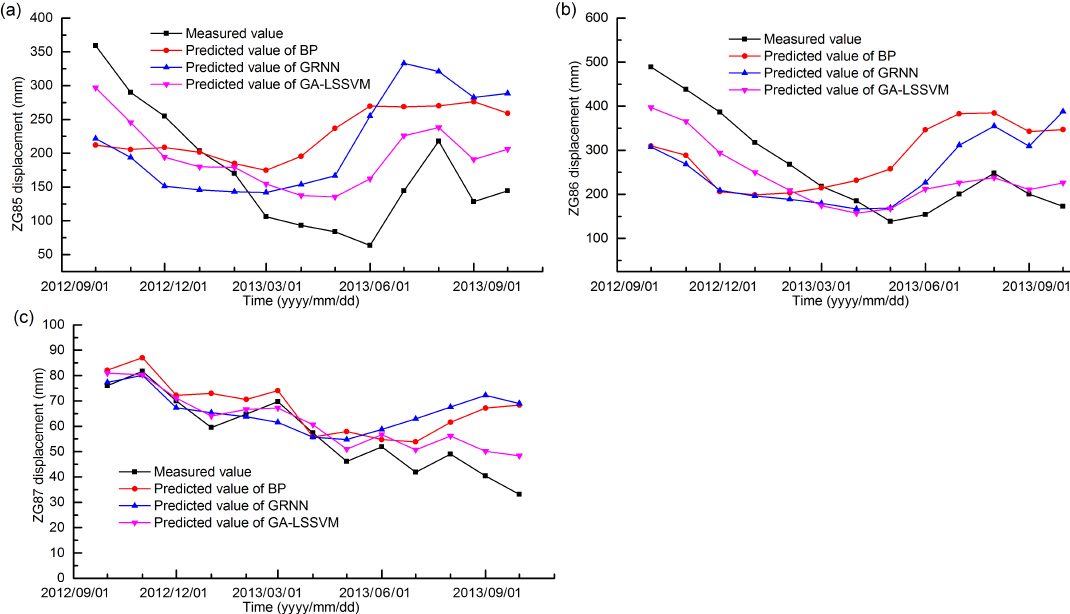
Figure 12. Measured displacement and predicted periodic displacement of Shuping landslide.